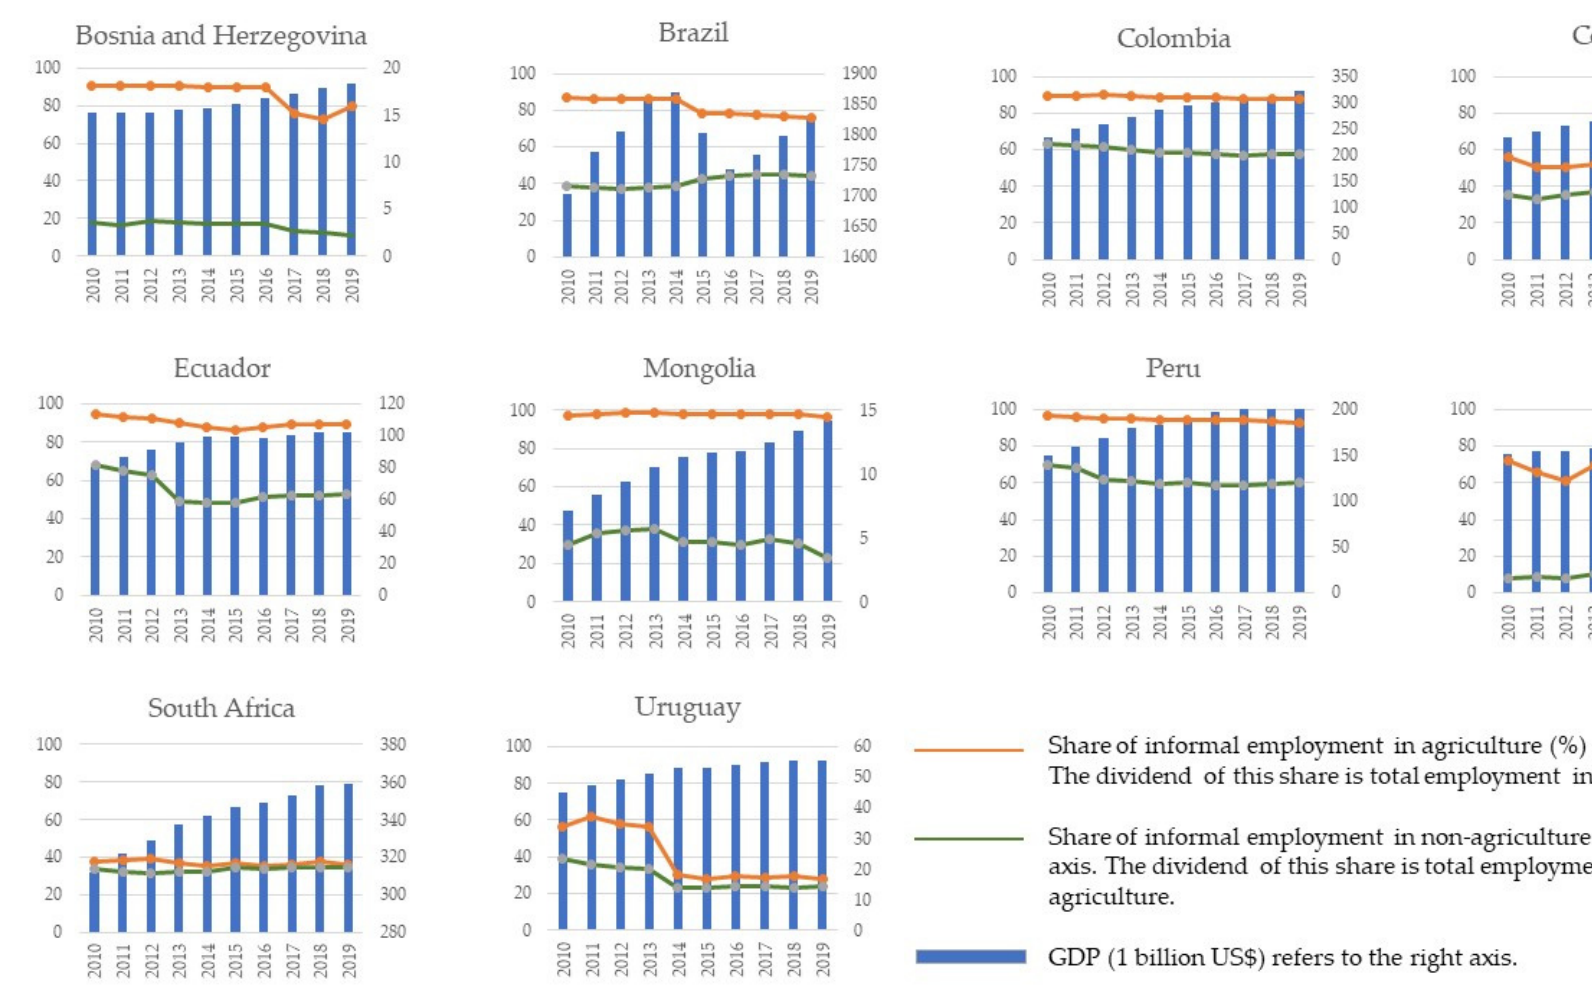
Figure 3. Share of informal employment (agriculture and non-agriculture) and GDP (Constant 2015 US$) over the year 2010–2019. Data Source: ILOSTAT.